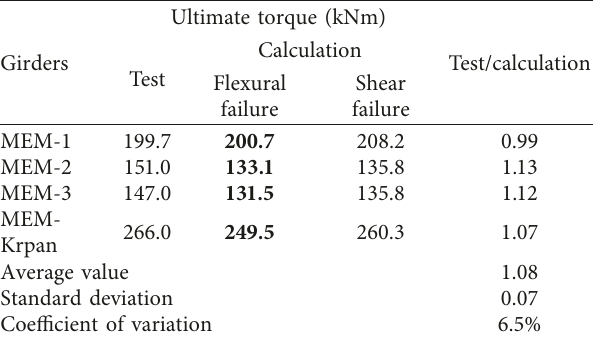
Figure 8: Test photo of the crack pattern on the external surface of the downward web. Table 2: Comparison of the calculated and tested ultimate